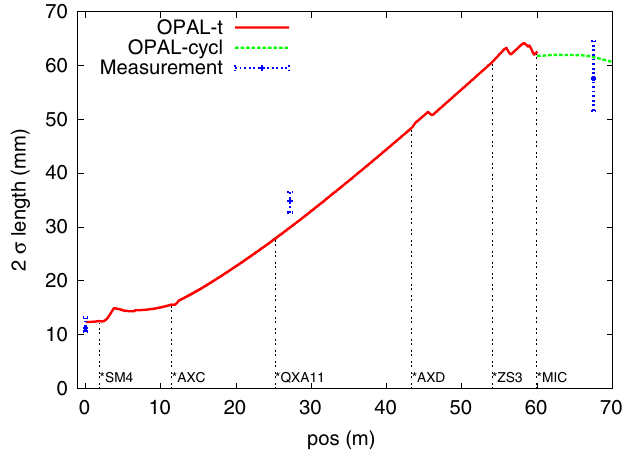
FIG. 3. Bunch length of the beam in the 72 MeV transfer line for a 2 mA beam (in Fig. 1 the positions of the time-structure measurements are shown).